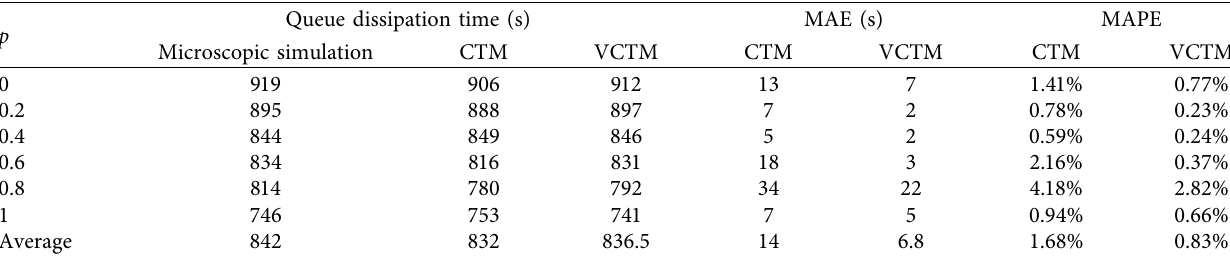
Figure 14: Density variation of CTM. Table 2: Comparison of microscopic simulation, CTM, and